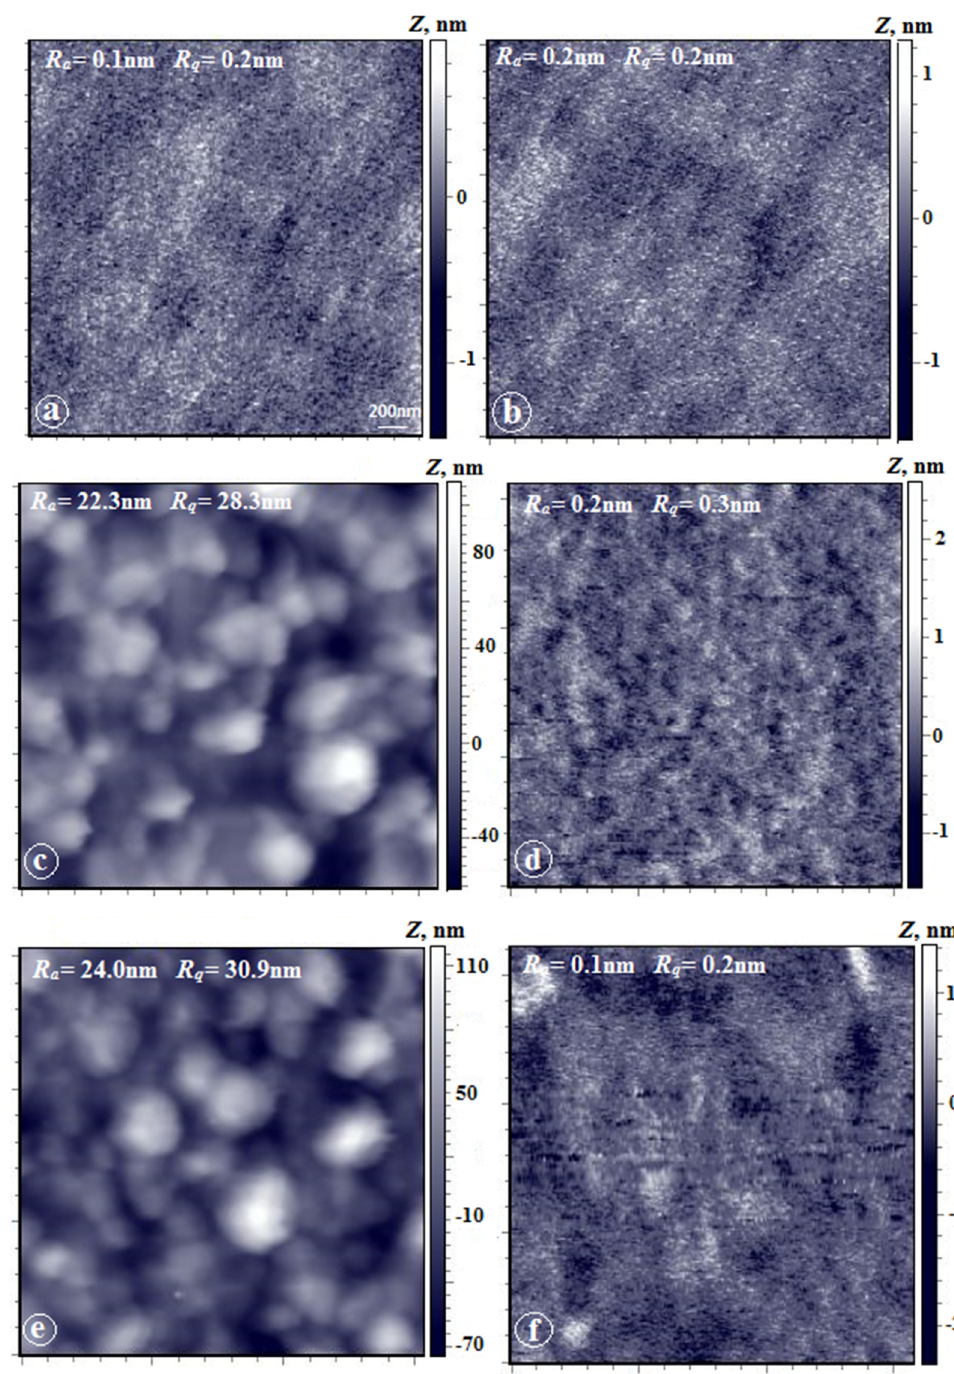
Figure 5. AFM height images of film surfaces: coPAI-1 ( a , b ), coPAI-2 ( c , d ) and coPAI-3 ( e , f ). Scan matrix size—3 × 3 µ m; ( a , c , e ) —the upper surface, ( b , d , f )—the substrate-side surface.